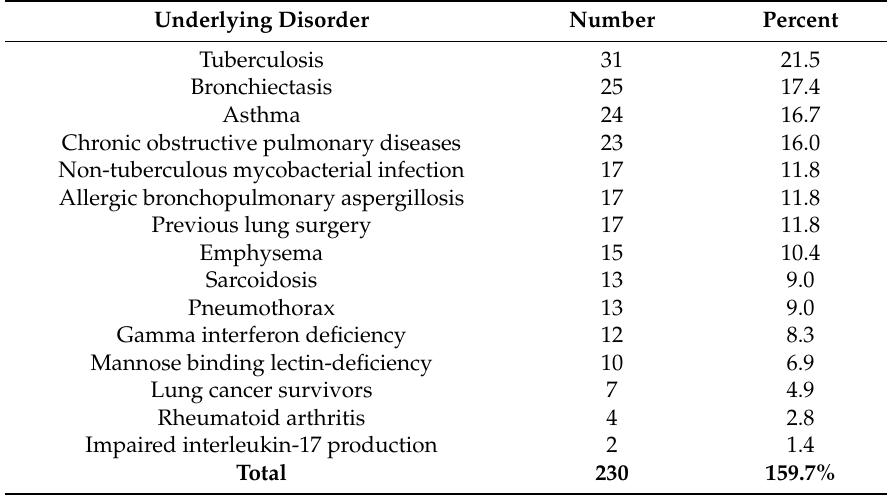
Table 2. Underlying conditions among the 144 patients with chronic pulmonary